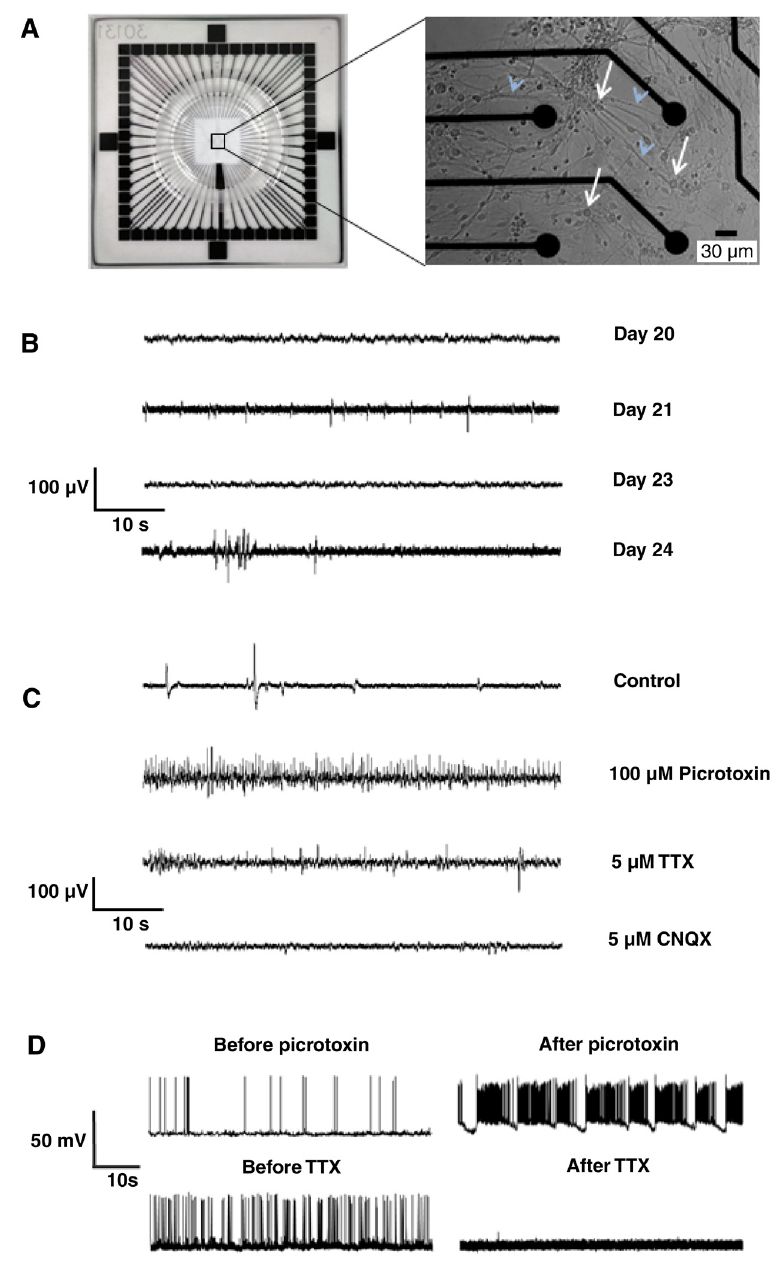
Figure 2. Myelinating cell cultures are spontaneously electrically active. A . Low power view of the whole MEA (left); all 59 recording electrodes and the ground electrode are concentrated in the center of the array. In the high-power image (right), four electrodes (black circles) can be observed in relation to the cell bodies (white arrows) and processes (including axons; blue arrowheads) of neurons and glia, on an MEA. To facilitate viewing, we selected a region in which cell density is lower than normal. Extracellular activity can be assessed from each of 59 recording electrodes. B . Extracellular recordings from a single electrode between 20 and 24. DIV. Each trace represents the sum of the activity detected at that electrode, which is in direct contact with multiple neuronal and glial cell bodies and processes. ‘Fast’ spike-like activity is evident at DIV 21 and ‘burst-like’ activity develops by DIV 24. C . Additive pharmacology on a DIV 24 culture (sequential administration of drugs without washout) demonstrates in vivo -like neuronal network activity of spinal cord myelinating cultures. The recording shows that addition of picrotoxin, a GABAergic inhibitor, evokes a massive increase in ‘fast’ neuronal activity (second versus first trace). Subsequent addition of TTX (a Na + channel blocker) inhibits much of the ‘fast’ spike-like (presumably axonal) activity. CNQX (a blocker of AMPA/kainate receptors) blocks excitatory synaptic activity. The remaining slow potential changes probably represent local spontaneous depolarizations (at neuronal and glial cell bodies). D . Examples of whole-cell current clamp recordings from single cells, presumably neurons, firing spontaneously at a resting potential of around -50 mV. Top, trace before and 5 minutes after the addition of 1 μM TTX (top). Bottom, trace from a second cell before and 5 minutes after the addition of 100 μM picrotoxin. TTX consistently blocked activity (n = 6 cells), as expected, whilst picrotoxin caused regular burst spiking in every cell tested (n = 18 cells), but the effect on overall spike rate was inconsistent, presumably reflecting the phenotype of the cell.